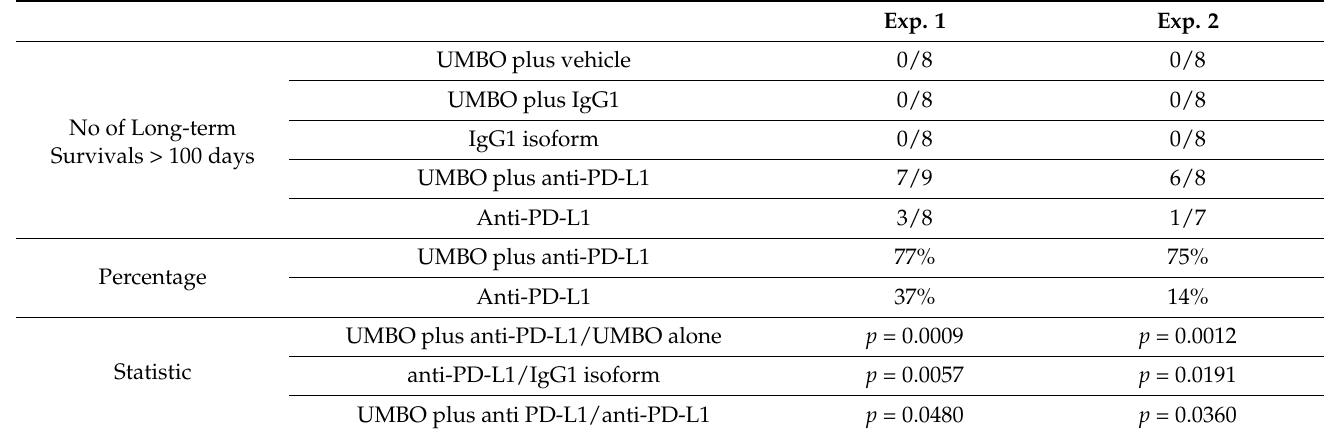
Table 1. Summary of long-term survivals and statistical analyses.